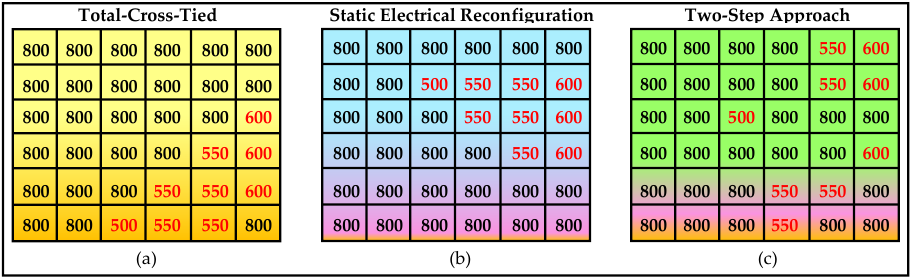
Figure 13. Irradiance received by the 6 × 6 PV array during partial shading S4 for ( a ) conventional, hybrid and TCT, ( b ) static electrical reconfiguration (shade dispersion), and ( c ) the two-step approach (shade dispersion).